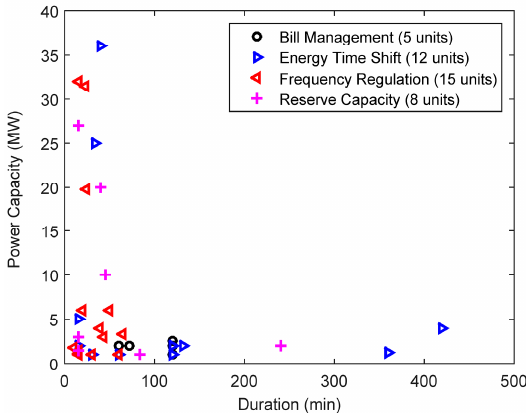
Figure 1. Electrochemical energy storage systems (ESS) installations over 1 MW in the United States (August 2015) classified by their primary use, based on the data provided in [3].